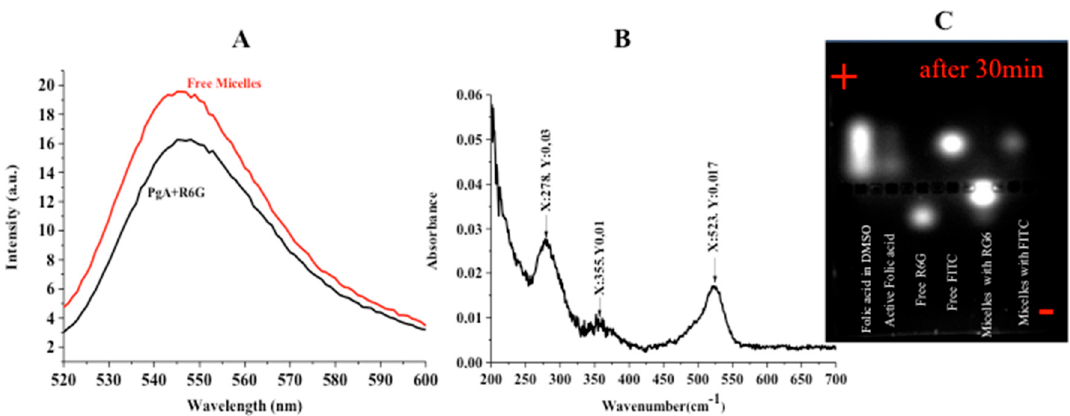
Figure 4. Measurement of nano-micelles markers. ( A ) Fluorescence spectrophotometry; ( B ) Absorbance spectrophotometry; ( C ) Agarose Gel separation (after 30 min).